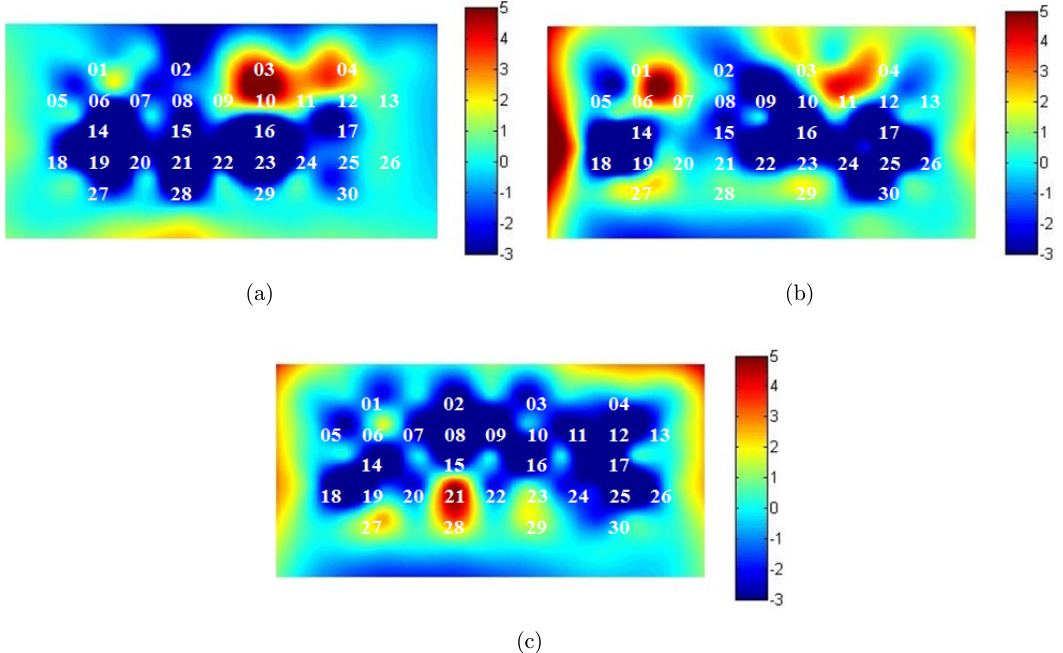
Fig. 3. Brain activation map ( t -map) of the primary RGB colors displayed on a white screen beamed by a projector (averaged over